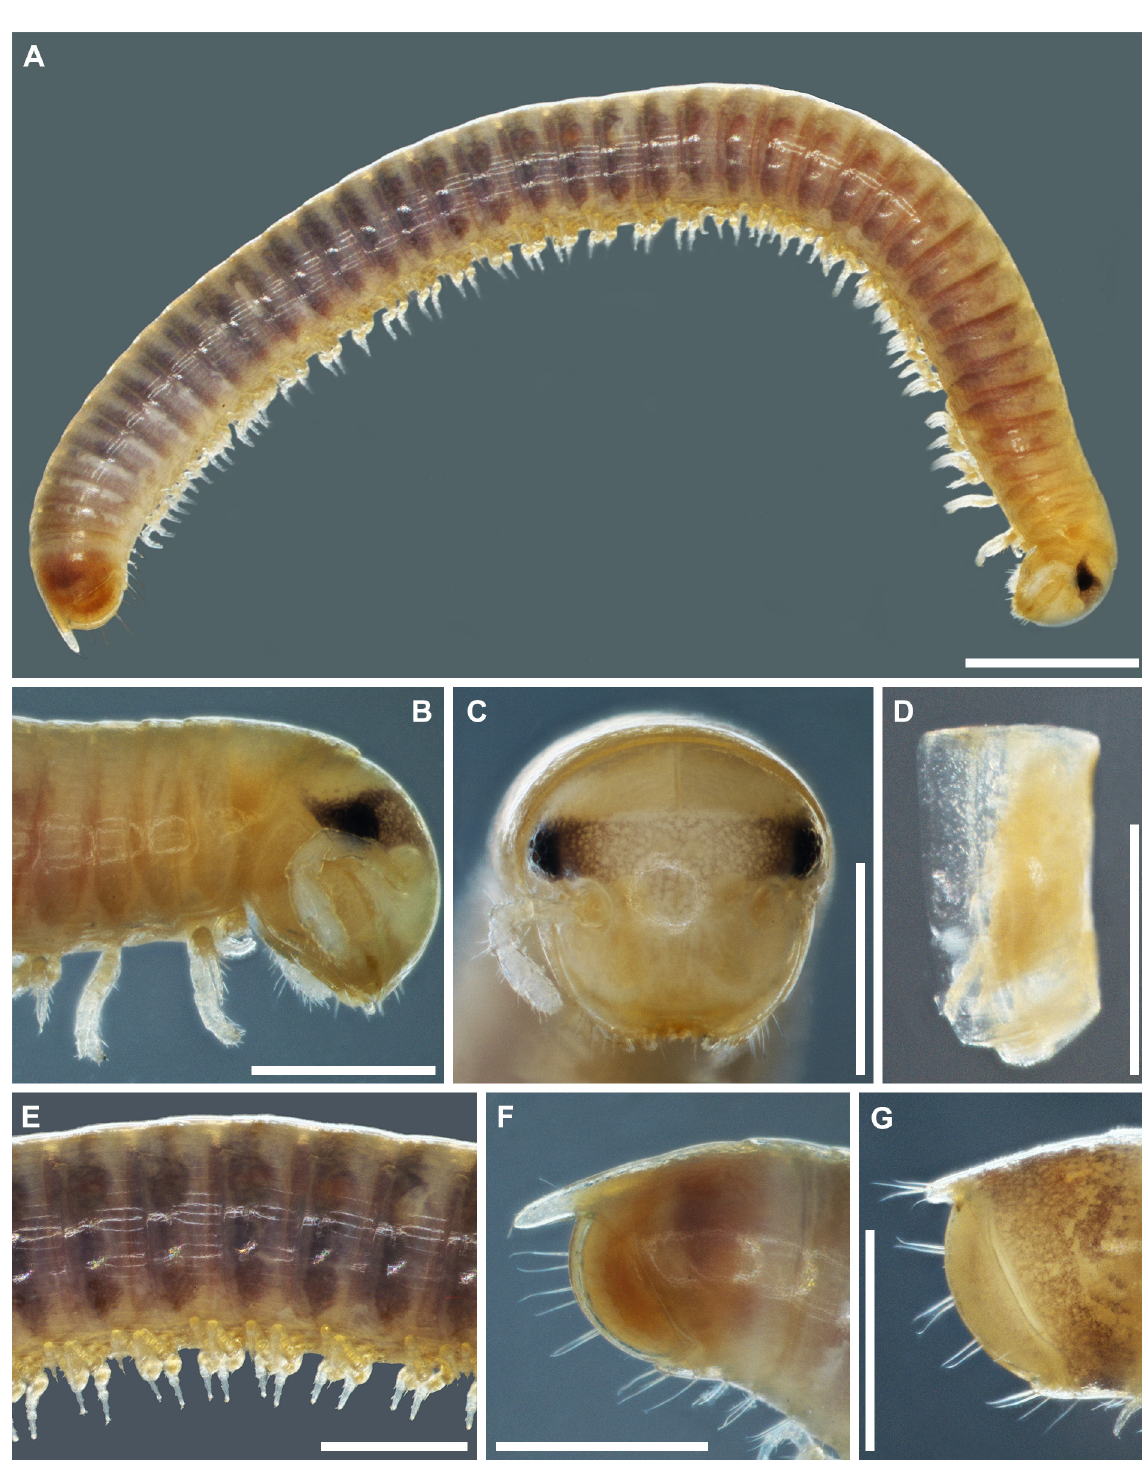
Fig. 29. Leucogeorgia oculata sp. nov., from Lagonaki Plateau (ZMUM). A . Holotype ♂, habitus, lateral view. B . Holotype, anterior part of body, lateral view. C . Paratype ♀, head, anterior view. D . Non-type ♂, body ring 7, lateral view. E . Holotype, midbody rings, lateral view. F . Holotype, telson, lateral view. G . Non-type ♂, telson, lateral view. Scale bars: A, E = 1 mm; B–D, F = 0.5